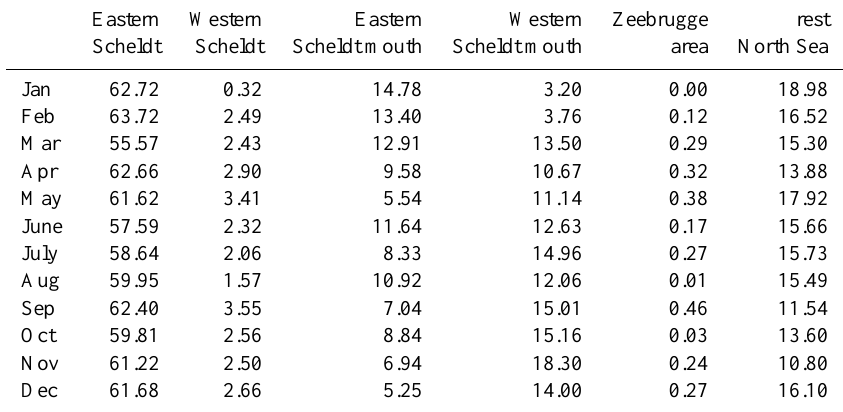
May 61.62 3.41 5.54 17.92 June 57.59